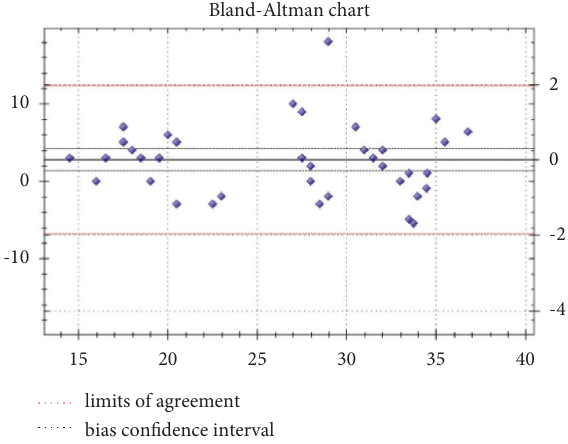
Figure 3: Te analysis of RdRp results using the Bland and Altman method (results on QS5 thermal